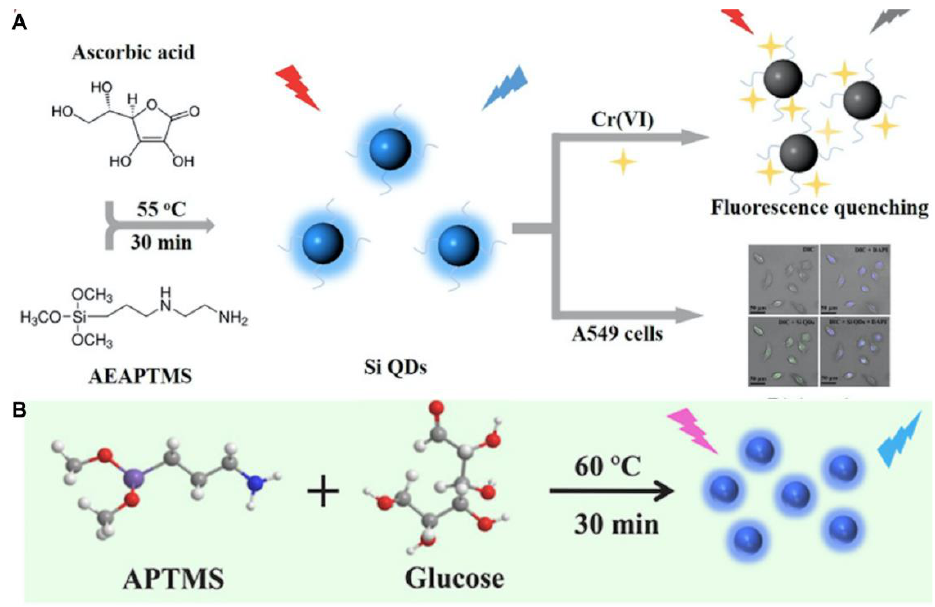
Figure 3. ( A ) Schematic illustration of the detection of Cr(VI) and bioimaging using SiQDs as a photoluminescent probe. Reproduced from [52], with permission from Elsevier, 2018. ( B ) Schematic illustration of the SiQD synthesis process. Reproduced from [54], with permission from Elsevier, 2022.